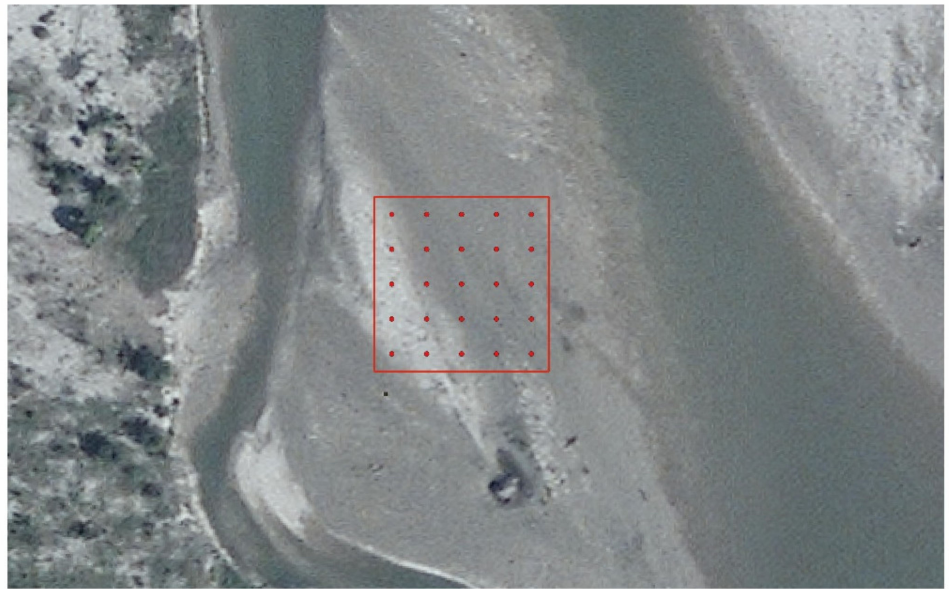
Figure 5. Example of a sampled pixel (red square) and its sub-sample